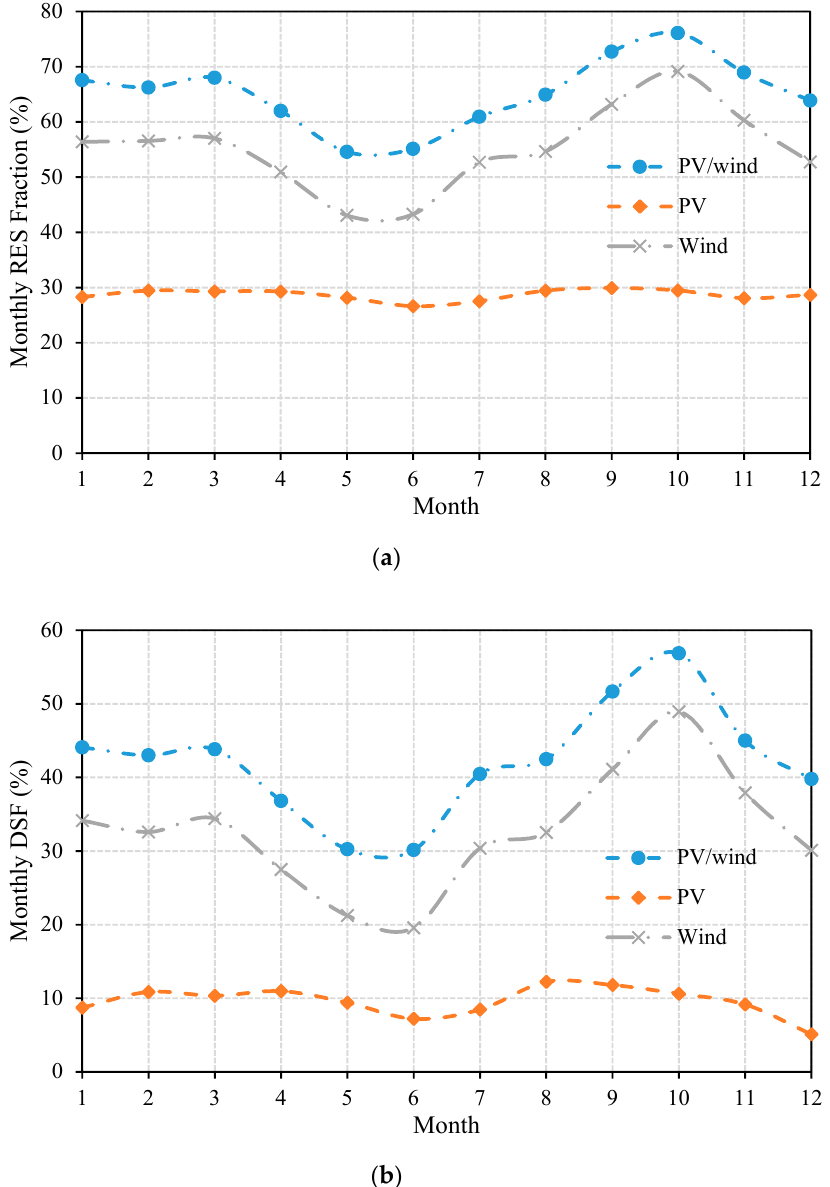
Figure 5 . The monthly technical parameters of the maximum feasibly RESs: ( a ) RES fraction and ( b ) demand supply fraction. Table 3 . Techno-economic comparison of different systems at similar geographic locations in Africa.